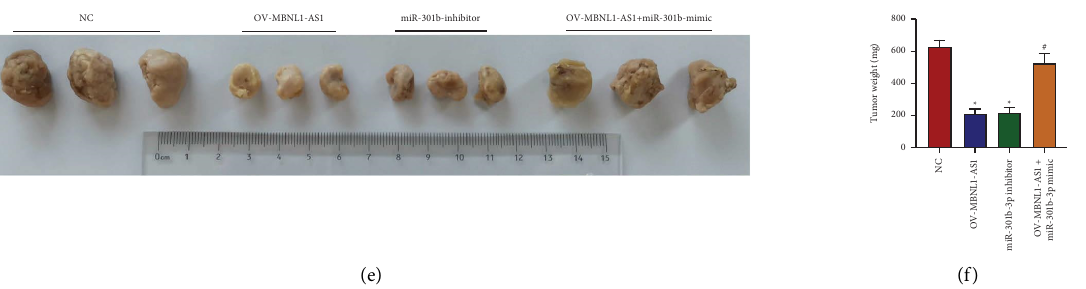
Figure 4: MBNL1-AS1 suppressed cell proliferation in PAAD by targeting miR-301b-3p. (a) Verifcation of efect of transfection with miR-301b- 3p inhibitor or miR-301b-3p mimic and pcDNA-MBNL1-AS1 in PANC-1 and SW1990 with diferent intervention. (b) Cell viability in PANC-1 and SW1990 with diferent intervention at diferent time. (c) Cell apoptosis in PANC-1 and SW1990 with diferent intervention. (d–f), Te